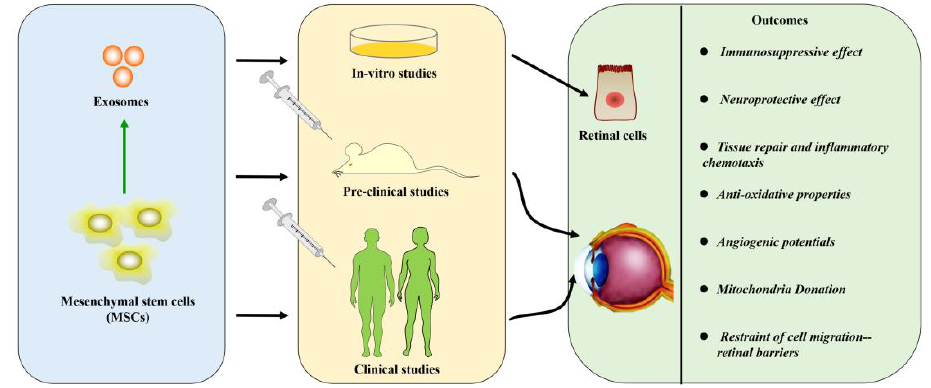
Figure 2. Potential effects and mechanisms for treating retinal diseases with mesenchymal stem cells.